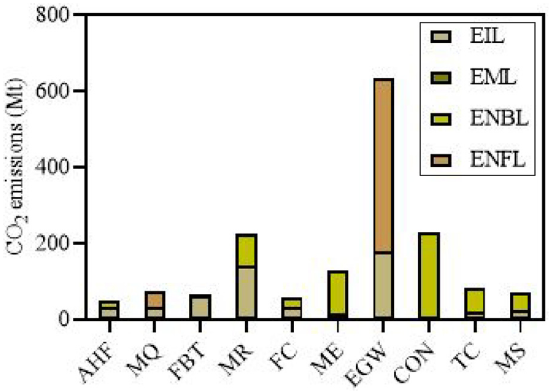
Figure 3. Decomposed emissions from EIL, EML, ENBL and